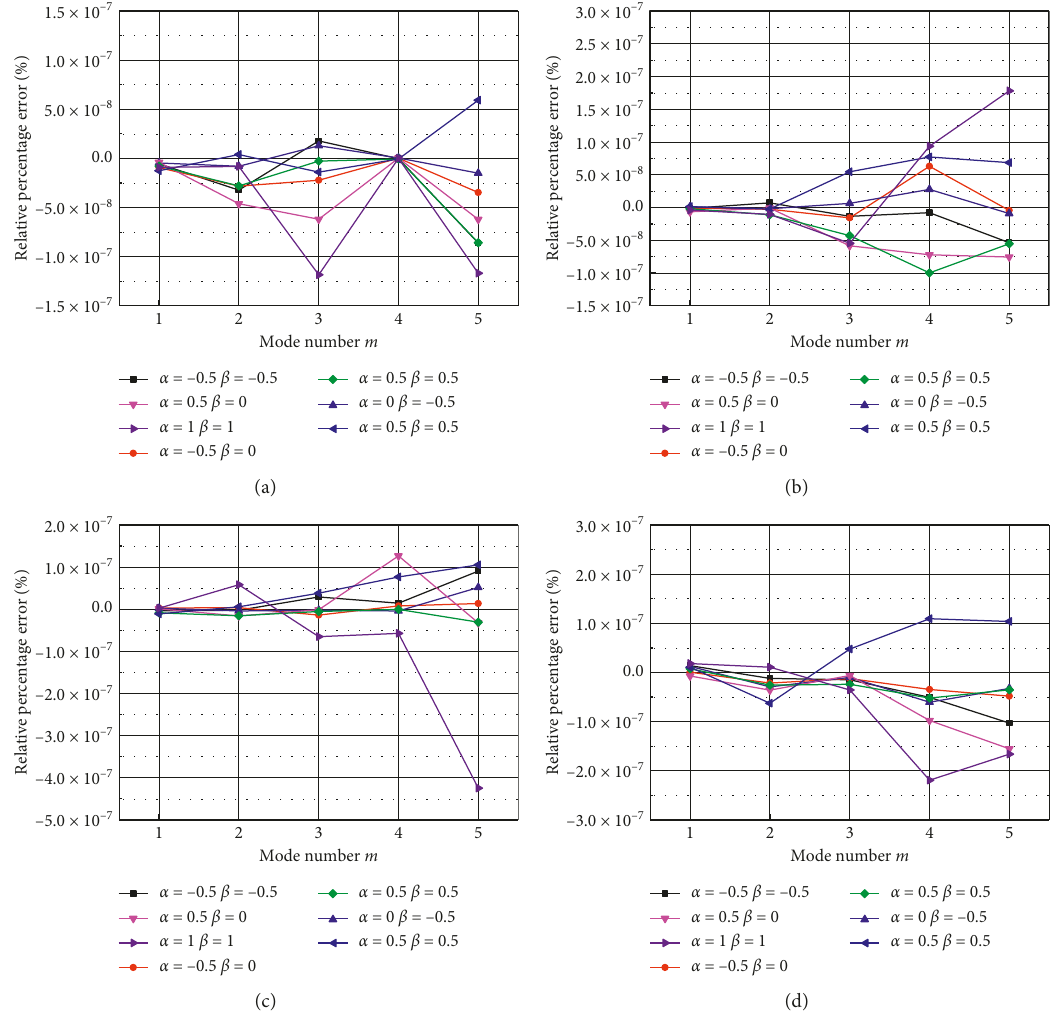
Figure 6: Relative percentage error of FG spherical shell with different Jacobi parameters. (a) n